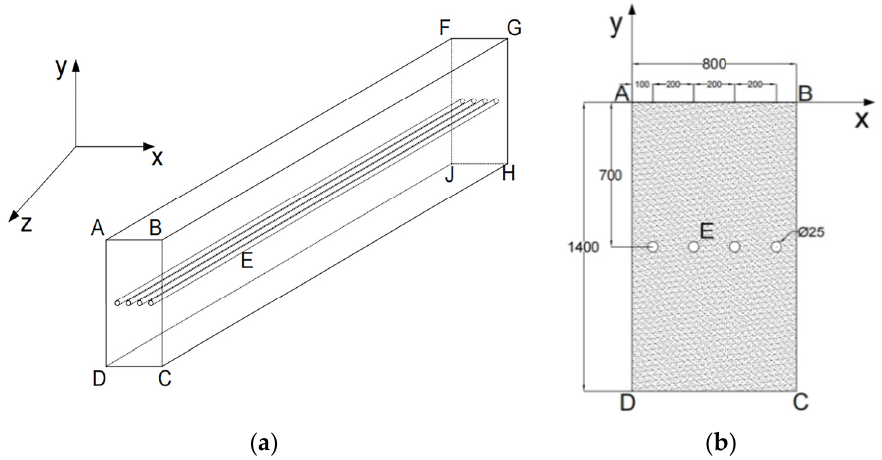
Figure 11. Physical model of horizontal heating pipe and surrounding soil. ( a ) Isometric view and ( b ) sectional view.